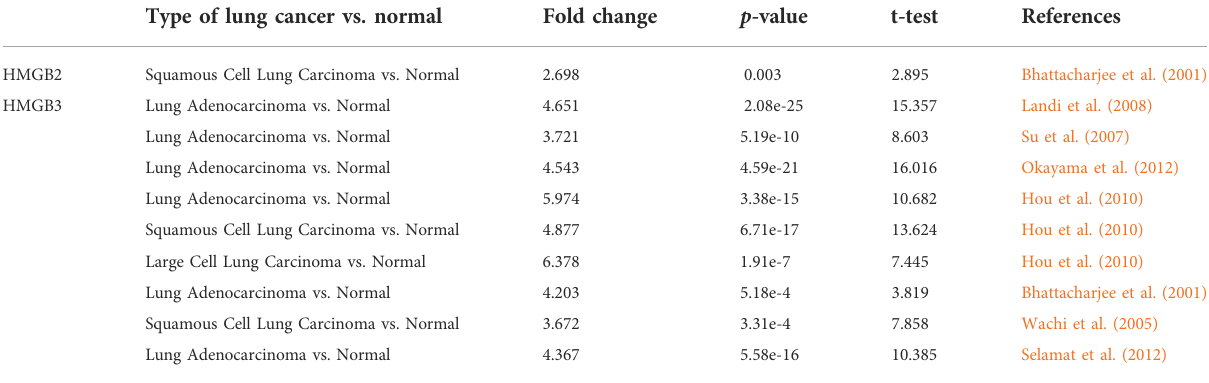
TABLE 2ONCOMINEanalyses indicating signi fi cant differences inmRNA expressionof HMGB family members between lungcancerandnormal lung tissue. Type of lung cancer vs. normal Fold